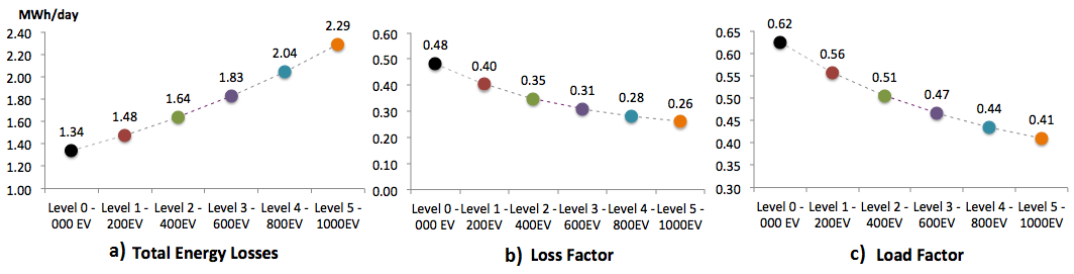
Figure 9. Peak load scenario: energy losses, loss and load factors by EV penetration level: ( a ) total energy losses; ( b ) loss factor; ( c ) load factor.